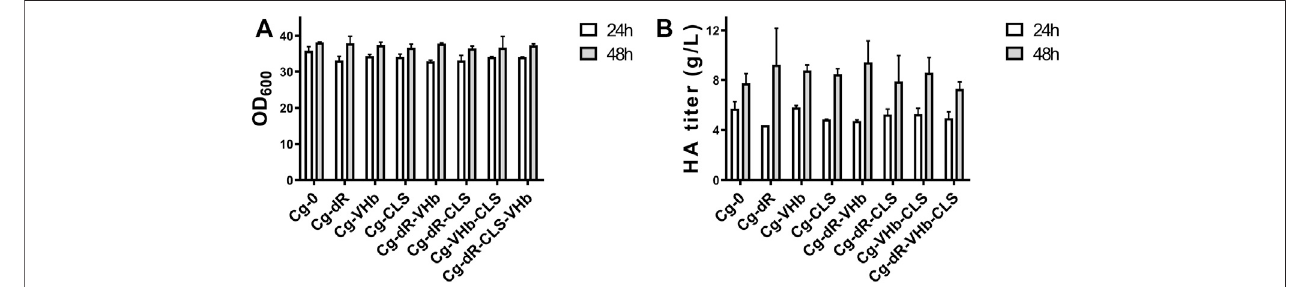
FIGURE 5 | Combination of different indirect genetic strategies on cell growth and HA synthesis. (A) OD 600 of different strains. (B) The HA titer of different strains. Strain Cg-0 was the control. Experiments were performed in